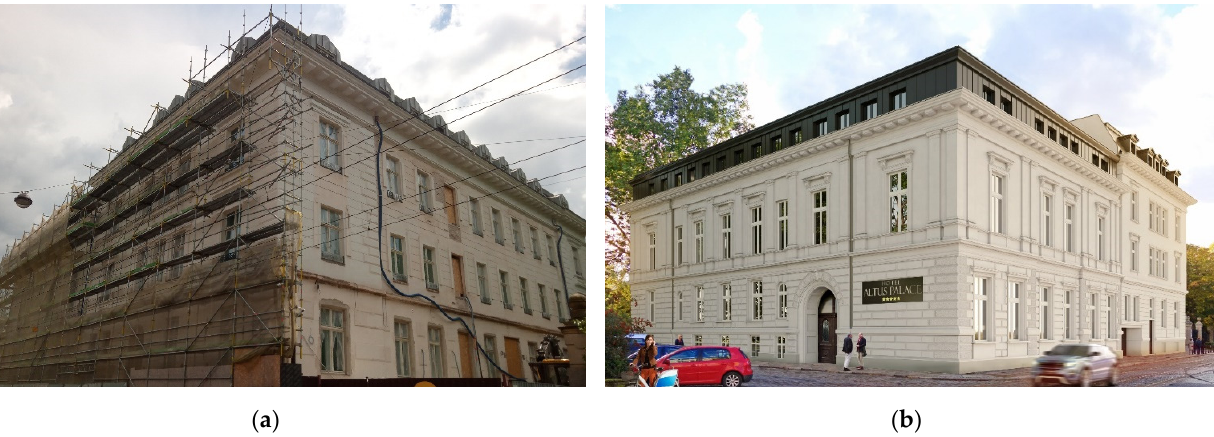
Figure 1. Former Leipziger Palace in Wroc ł aw: ( a ) view on the facade during reconstruction; ( b ) facade visualization after reconstruction to the hotel building.